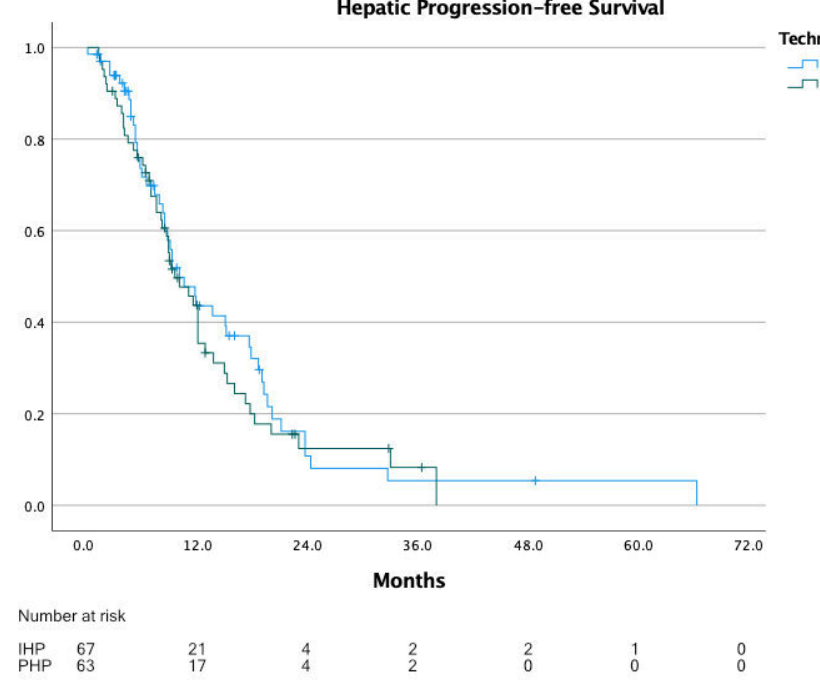
Figure 5. Hepatic progression ‐ free survival.